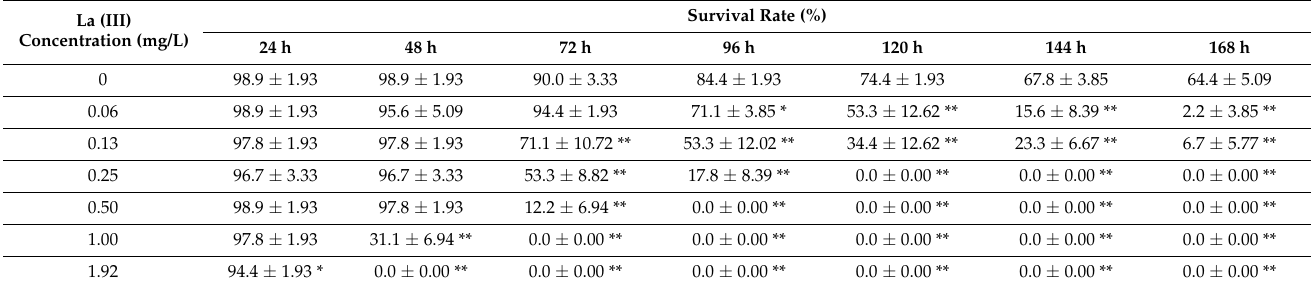
Table 1. Table 1. Survival rates following exposure of rare minnows to different levels of La (III) for varying durations.